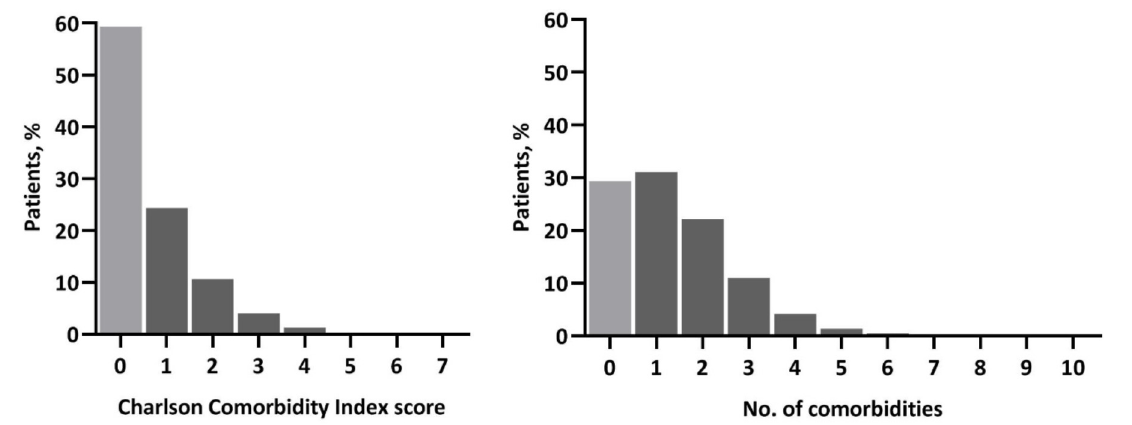
Figure 1. Distribution of comorbidity by measurement